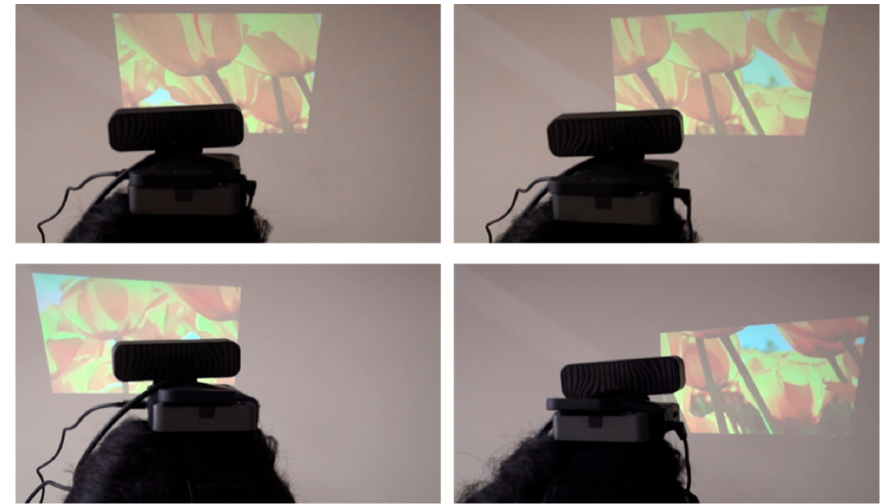
Figure 5. Images displayed when the user’s head moved, taken from behind the head. The images are always in the direction of the user’s gaze, and the virtual information space is fixed on the surface.